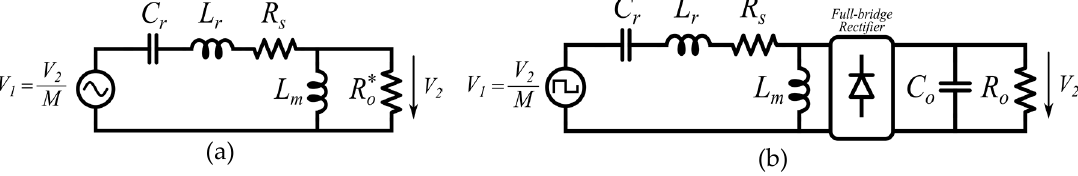
Figure 7. ( a ) Modified FHA LLC equivalent circuit with series resistance; ( b ) time-based (TB) LLC circuit with series resistance.